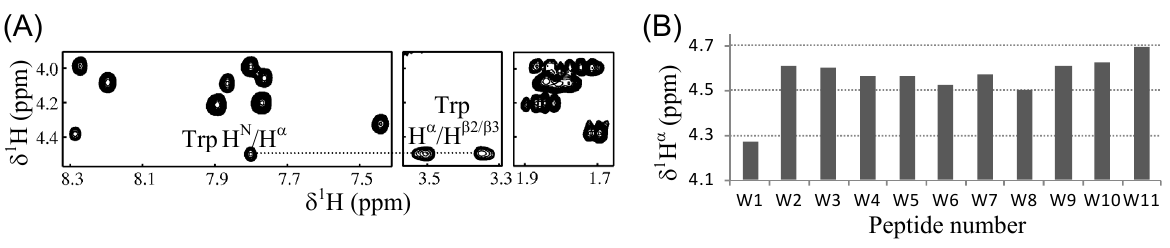
K W n model peptides. ( A ) Selected regions from the Figure 4. NMR analysis of the L 5 5 2D-COSY spectrum of the W8 peptide in 50% TFE solution are aligned to present the 1 H α - 1 H β  β  connectivity of the tryptophan residue (dotted line); ( B ) Tryptophan 1 H α chemical shifts of individual peptides in the 50% TFE solution are